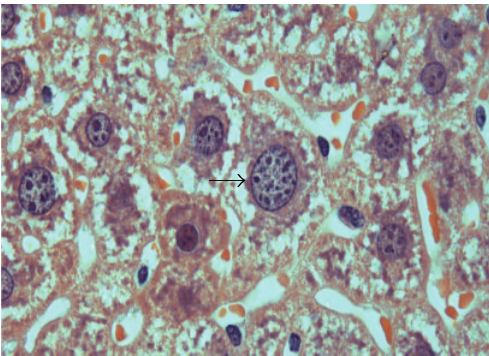
Figure 4: Meganucleated hepatocytes (arrow) were observed in the group of animals exposed to inhaled vanadium pentoxide.